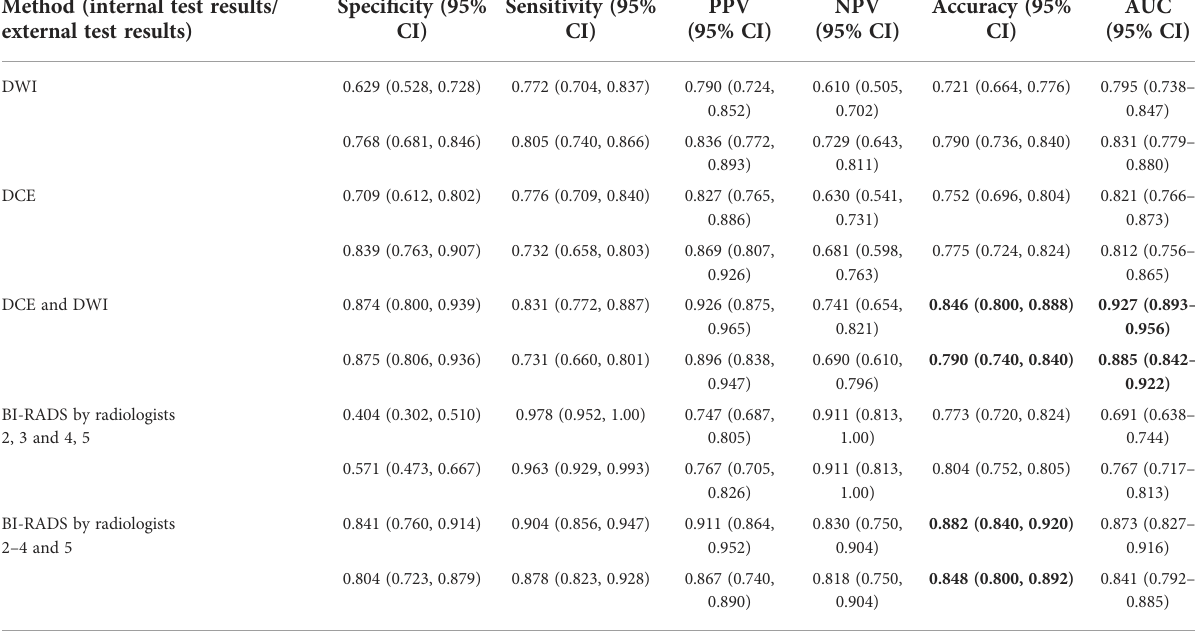
TABLE 3 The diagnostic performances of the characterization models and radiologists. Method (internal test results/ external test results)